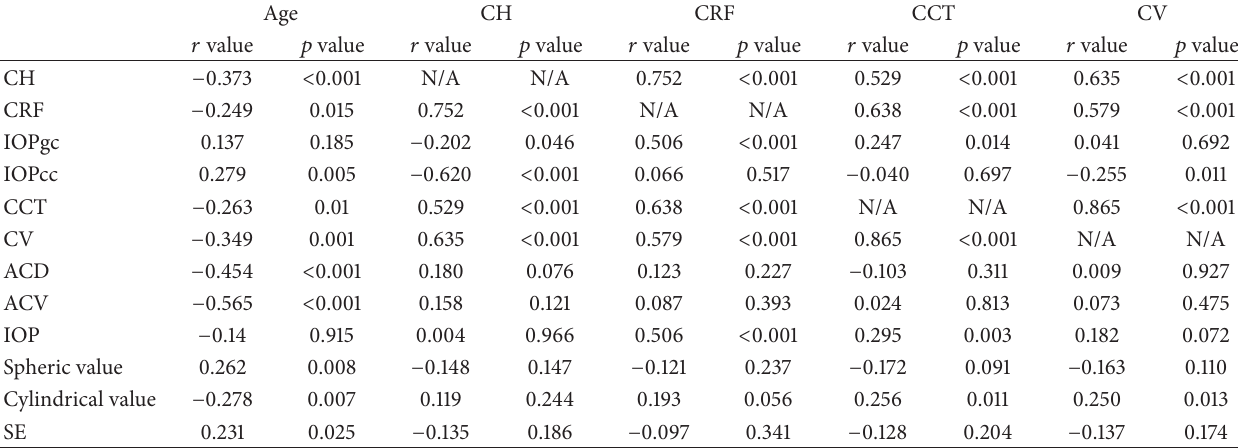
Table 2: The relationship of CH, CRF, CCT, and CV with IOPgc, IOPcc, anterior segment parameters, and refraction values.